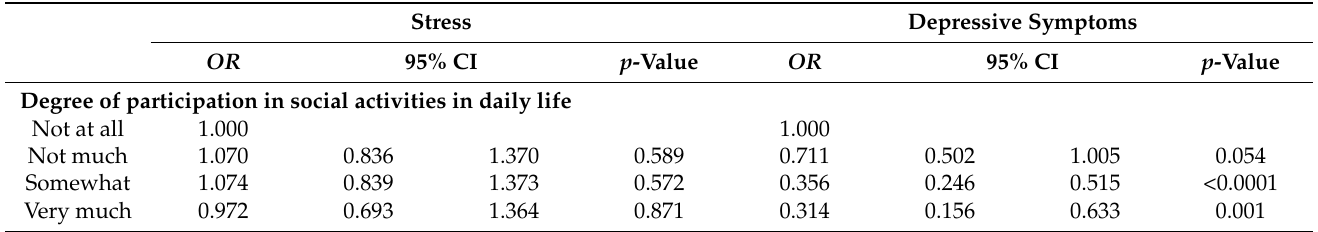
Table 3. Association between degree of participation in social activities and mental